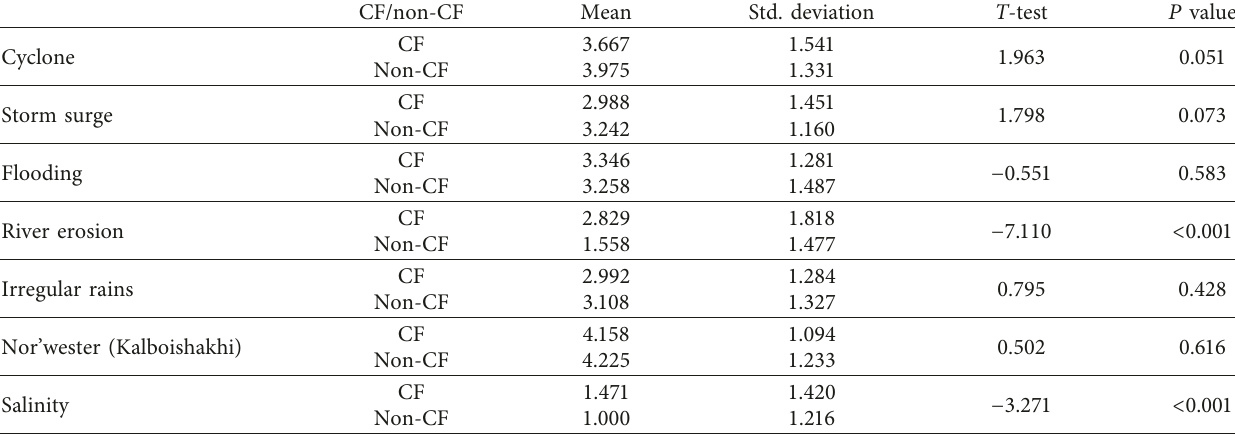
Table 5: Mean, standard deviation, and standard error of the perceived probability, i.e., likelihood of facing the climatic events in the future. CF/non-CF Mean Std. deviation